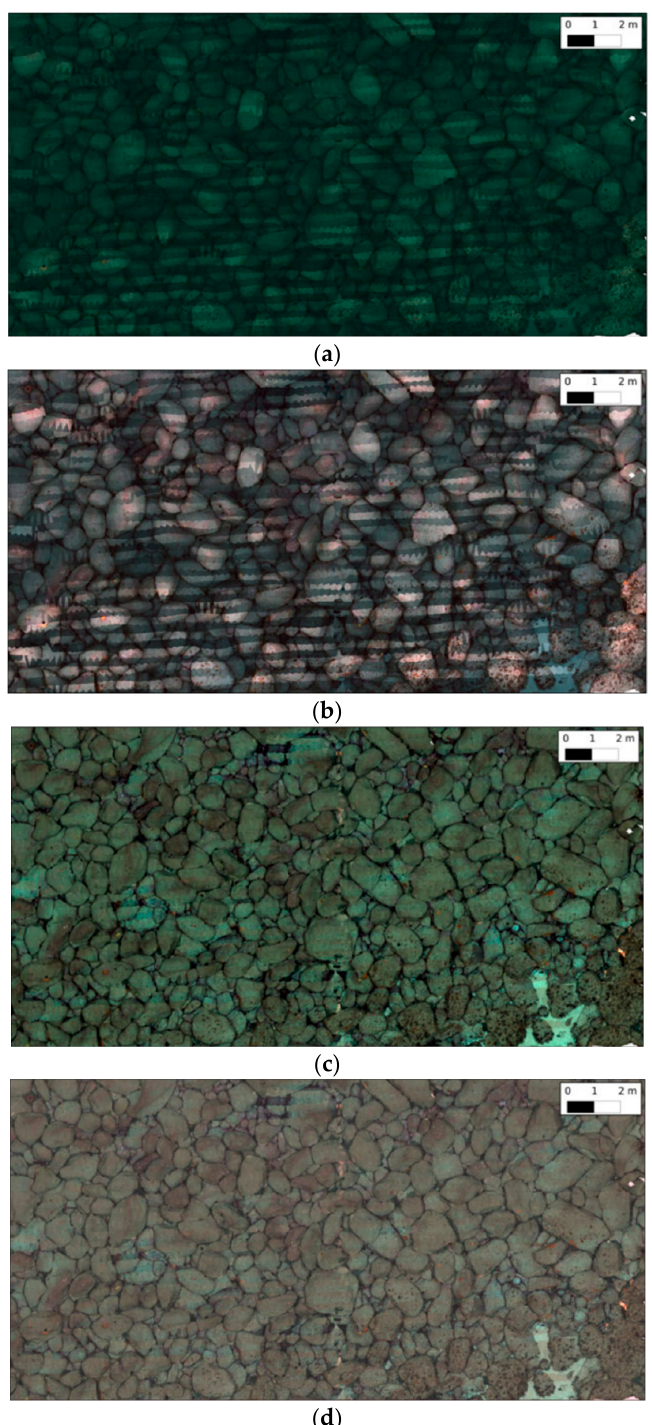
shown in Figure 5 below.